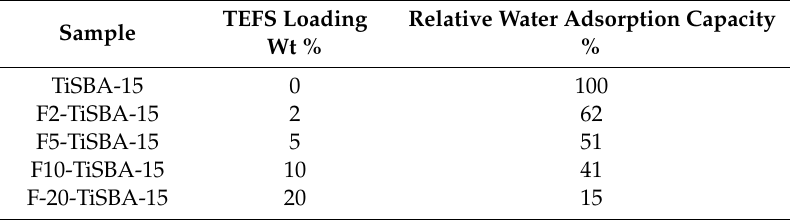
Table 6. Relative water adsorption capacity compared to TEFS loading on TiSBA-15 at P / P 0 = 0.6 [53].